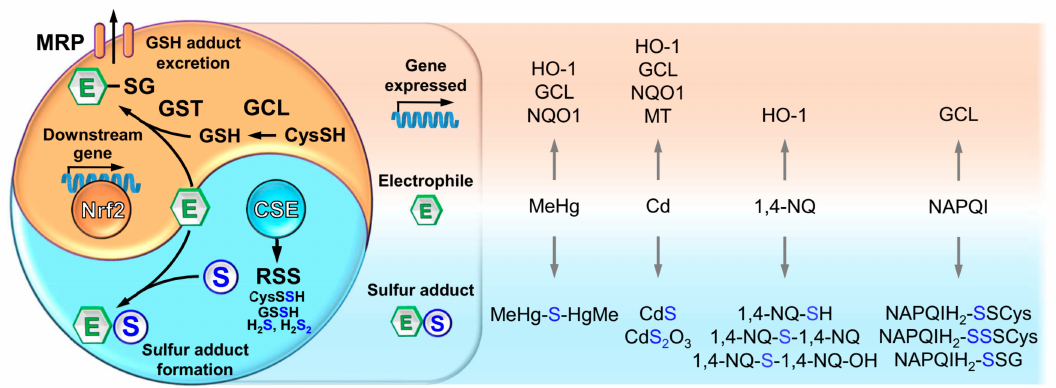
Figure 4. The Nrf2 and CSE pathways contribute to the elimination of electrophilic stress in a parallel manner. Nrf2 is a central coordinator for the induction of detoxifying genes that in turn are translated into proteins that are associated with GSH adduct formation and subsequent excretion into the extracellular space (e.g., GCL, GST and MRP). Aside from Nrf2, RSS generation mediated by CSE contributes to detoxifying electrophiles through sulfur adduct formation. For various electrophiles, upregulated genes and sulfur adducts have been uniquely identified (gray